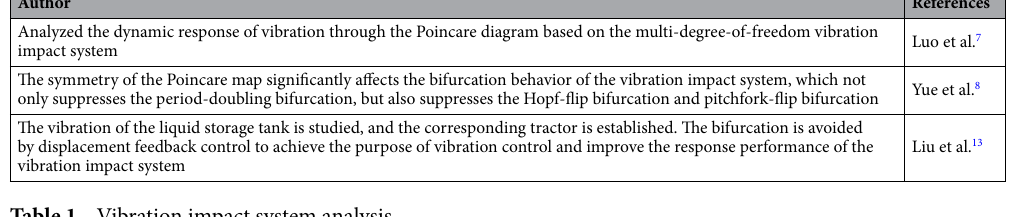
Table 1. Vibration impact system analysis.